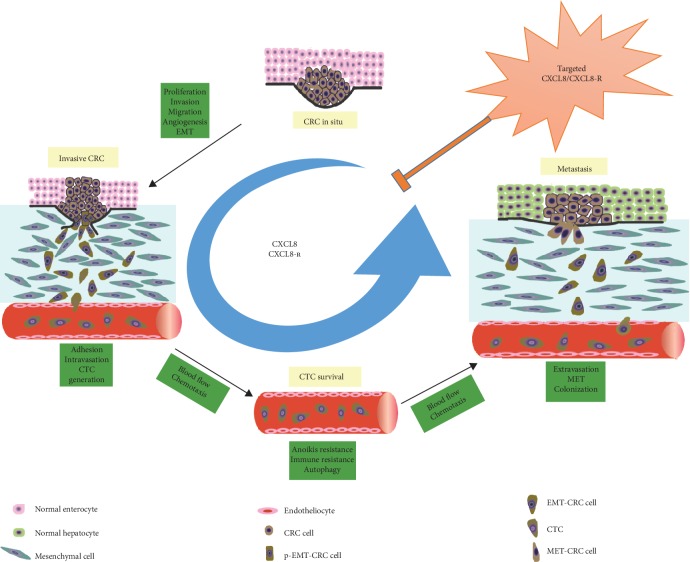
CXCL8 and its receptors (CXCL8-R) are involved in almost the entire process of colorectal cancer progression and metastasis. First, CXCL8 and CXCL8-R promote CRC cell proliferation, invasion, migration, and angiogenesis and induce the epithelial-mesenchymal transition (EMT) of CRC cells, which contributes to the adhesion and intravasation of CRC cells to the blood. When tumor cells intrude into the blood, they are called CTCs, and most are killed by immune effector cells. However, a small number of them can evade immune surveillance and survive in the blood, which cannot be separated from the role of CXCL8 in inducing the anoikis resistance of CTCs, immune resistance, and autophagy. As a result of blood flow and the chemotaxis of the CXCL8 axis, CTCs may travel long distances, especially to the liver. After extravasation from the blood, the CRC cells induce the mesenchymal-epithelial transition (MET) and then colonize to form metastatic lesions. Targeting the CXCL8/CXCL8-R signaling axes may be a potential new therapeutic strategy to control cancer progression of and overcome drug resistance in colorectal cancer.